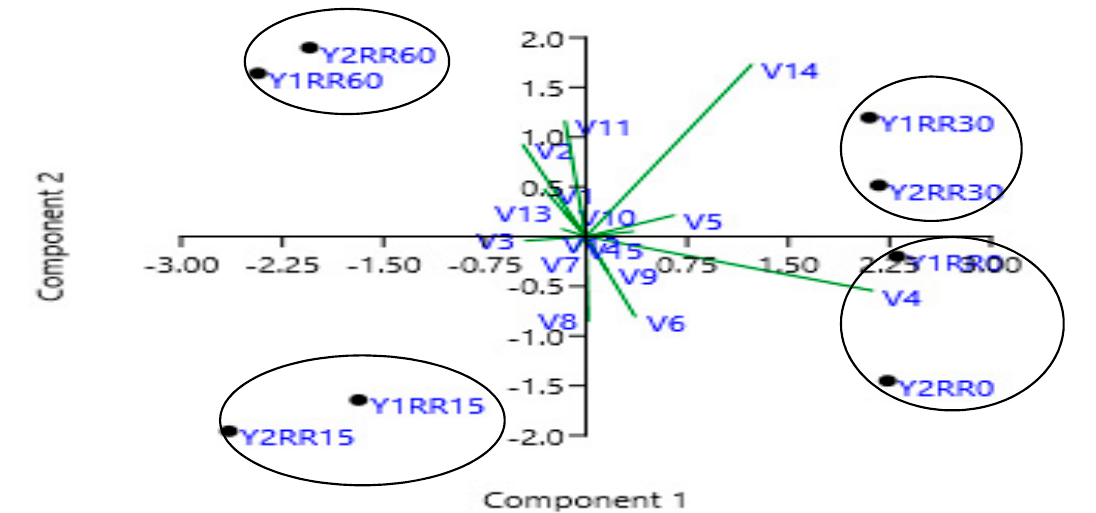
Figure 6. PCA analysis of occurrence of species and functional groups in various plots subjected to different intensity of RR: V1 = Eragrostis curvula, V2 = Cynodon dactylon, V3 = Digitaria eriantha , V4 = Setaria nigrirostis , V5 = Themeda triandra , V6 = Heteropogon contortus , V7 = Setaria sphacelata , V8 = Eragrostis barbinodis , V9 = Melinis repens, V10 = Brachiaria serrata , V11 = Aritida congesta, V12 = decreaser; V13 = increaser; V14 = forbs. Y1RR0 and Y2RR0 = 0% RR in 2017 and 2018, respectively, Y1RR15 and Y2RR15 = 15% RR in 2017 and 2018, respectively, Y1RR30 and Y2RR30 = 30% RR in 2017 and 2018, respectively, Y1RR60 and Y2RR60 = 60% RR in 2017 and 2018, respectively. Table 2. Annual net primary productivity (ANPP) of different functional groups as affected by different intensity of rainfall reduction (RR) in Pretoria.